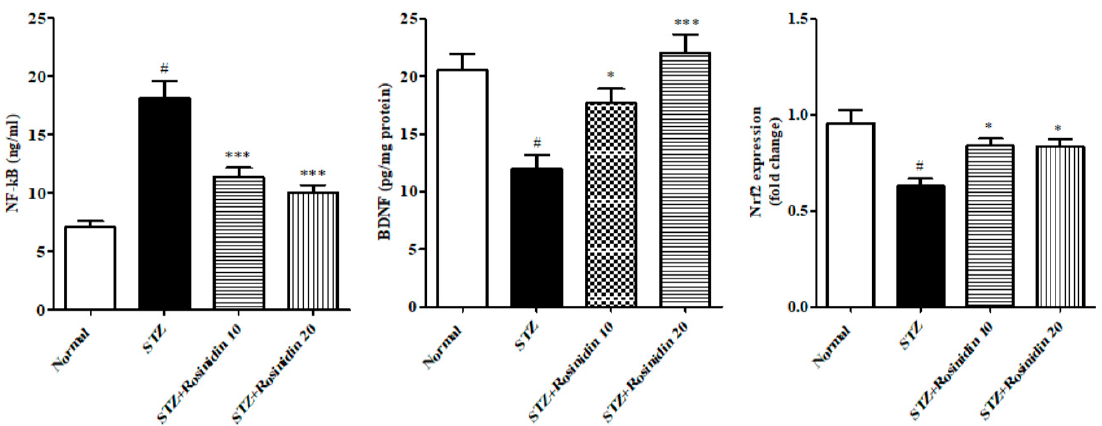
Figure 8. The effect of rosinidin on NF-kB, Nfr2, and BDNF proteins. All the values are presented as the mean ± SEM. Correlation among the groups was done using Tukey’s test by one-way ANOVA. p -value < 0.05, 0.001 were expressed as *, *** respectively as compared with the streptozotocin (STZ) group. # significant as compared with the controls ( p < 0.001).